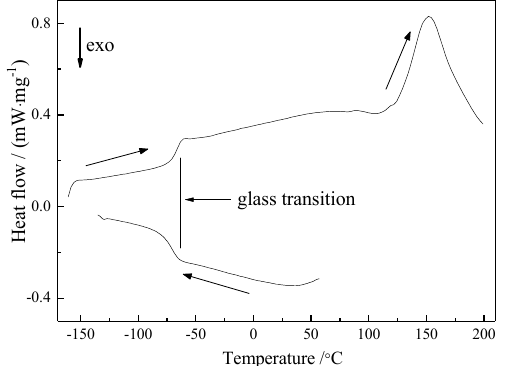
Figure 6. Differential scanning calorimeter (DSC) curve of [EMIm]F at the cooling and heating rate of 10 K/min.